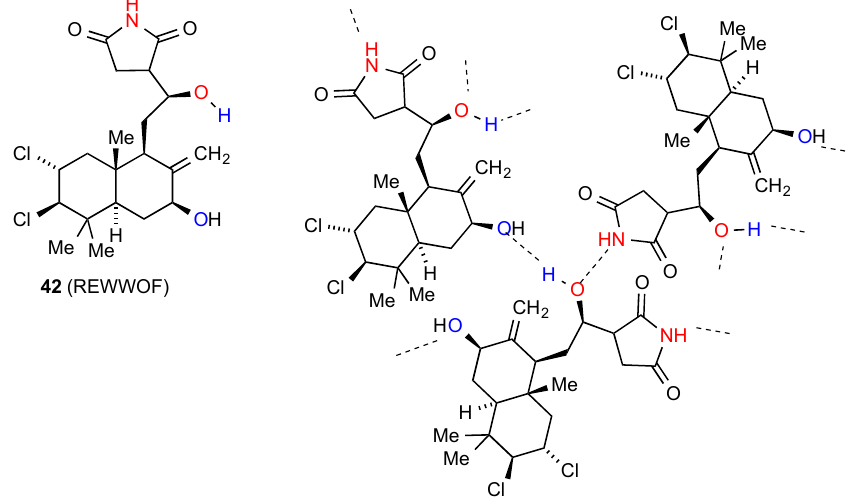
Figure 15. Structure observed for compound 42.